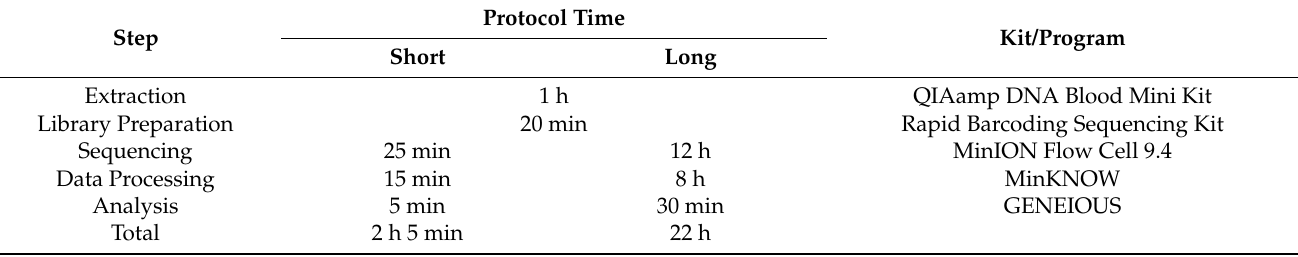
Table 1. Speed of the